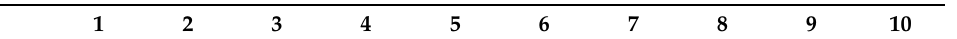
Table A2. Matrix of rotated